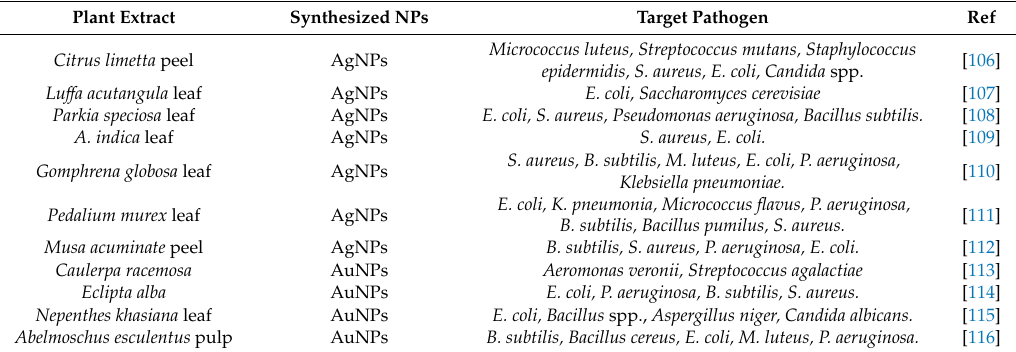
Table 1. Plant extract-mediated green synthesis of AuNPs and AgNPs with antimicrobial activity.